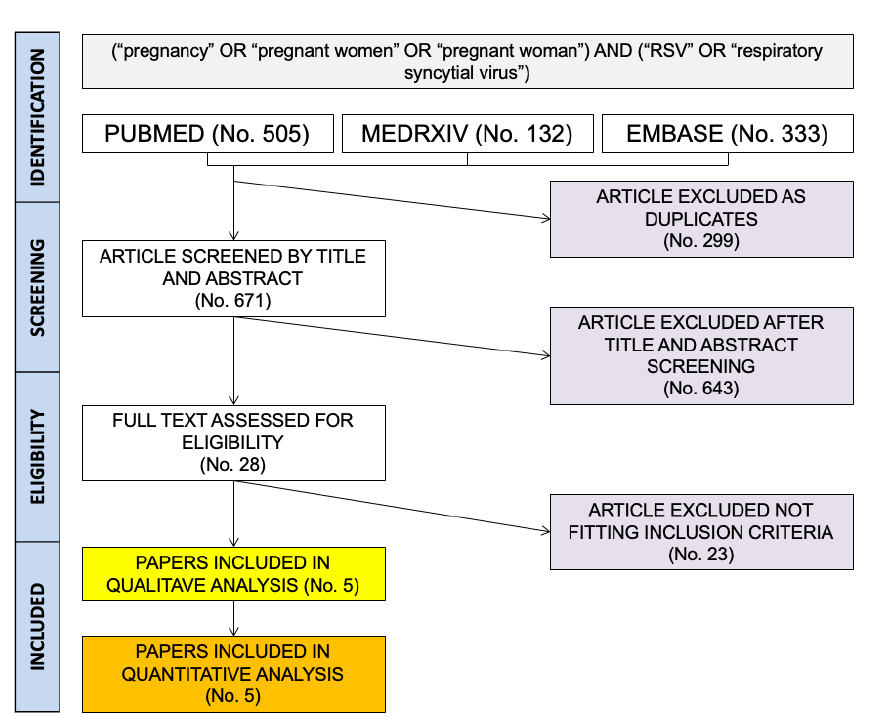
Figure 1. Flow chart for studies included in the systematic review and meta-analysis.